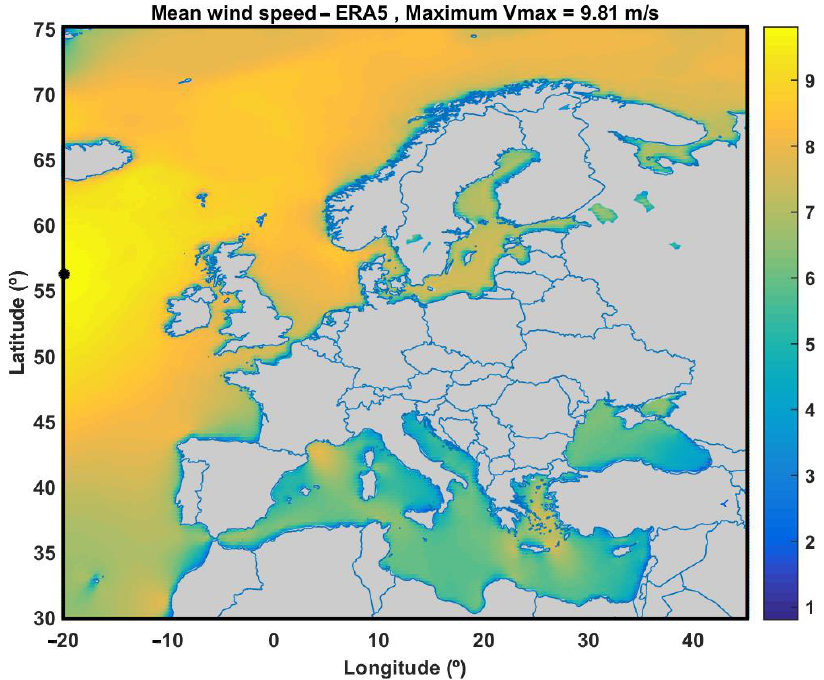
Figure 10. Mean wind speed for the Europe area.